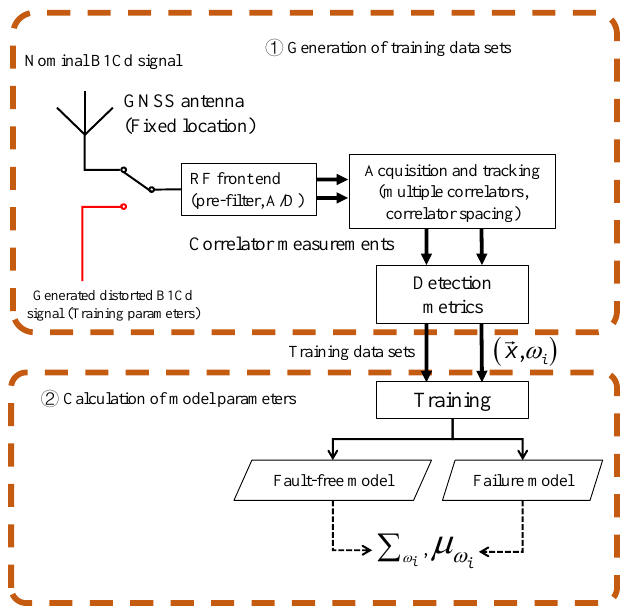
Figure 2. Offline training flow chart.